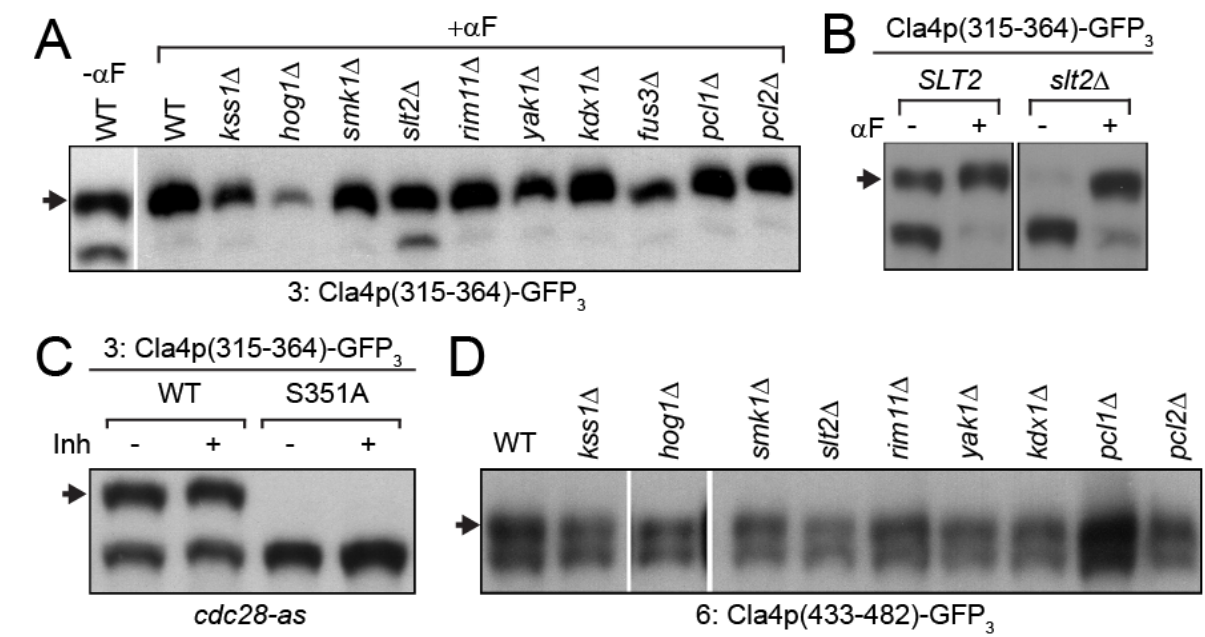
Figure 3. Screening for kinases responsible for Cla4p ‐ S351 and S445. ( A – D ) Samples were run on 50 μ M Phos ‐ tag gels and detected by anti ‐ GFP immunoblotting. Arrows indicate phosphorylated spe ‐ cies. ( A ) The Cla4p truncation (MR6289) was expressed in indicated mutant cells (MY10273, 11198, 13003, 13004, 13005, 13006, 13007, 13010, 13011, 13012, and 13013) under the GAL1 promoter for 90 min after α‐ factor arrest for 2 h. ( B ) The indicated Cla4p truncation (MR6289 and 6290) was ex ‐ pressed in SLT2 (MY11198) and slt2 Δ (MY13011) under the GAL1 promoter for 90 min during mito ‐ sis or after α‐ factor arrest for 2 h. ( C ) Actively growing cdc28 ‐ as1 (MY11198) was treated with DMSO or the inhibitor, 1 ‐ NM ‐ PP1, after which truncated proteins (MR6289 and 6290) were induced by the cells (MY11198, 13018, 13019, 13020, 13021, 13022, 13025, 13026, 13027 and 13028) under the GAL1